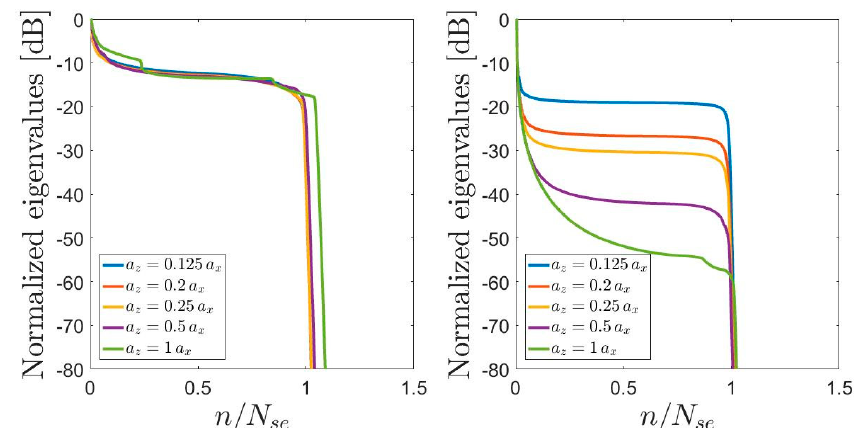
Figure 9. Normalized eigenvalue behaviors (reported in descending order) of L θ (left panel) and L u (right panel) operators for a semi-elliptic source when a x = 10 λ . Each line refers to a di ff erent aspect ratio a x /a z .